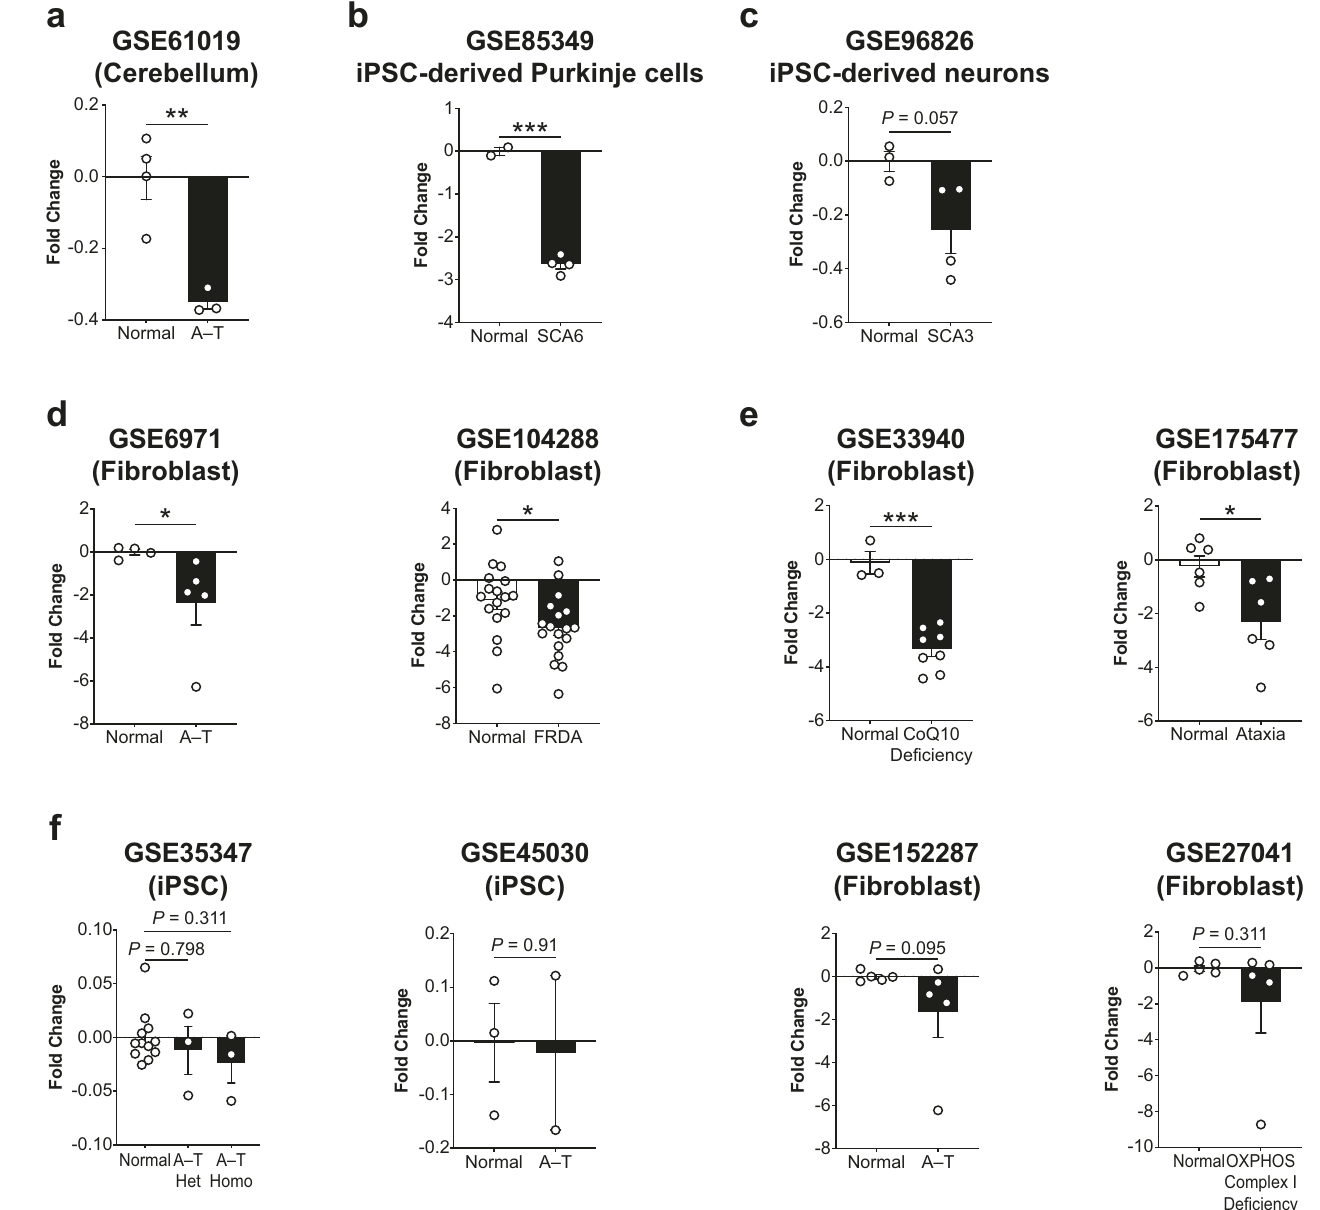
Fig. 7 GRIA1 expression is downregulated in patients with ataxic manifestations. a The mRNA expression of human GRIA1 was signi fi cantly reduced in the cerebellum of human patients with ataxia-telangiectasia (A-T). b and c Similarly, GRIA1 was downregulated in the patient iPSC- derived Purkinje cells (spinocerebellar ataxia 6) and neurons with (spinocerebellar ataxia 3). d and e GRIA1 expression were markedly reduced in the fi broblast cells derived from patients with A-T and Friedreich ’ s ataxia, and patients with ataxia symptoms. f There was a trend for GRIA1 to decrease in A-T patient-derived iPSC and fi broblasts, and fi broblast derived from patients with oxidative phosphorylation disease who exhibited ataxic manifestations. Values represent the mean ± SEM. * P < 0.05, ** P < 0.01, *** P < 0.0001; unpaired Student ’ s t -test for comparison between two groups, or one-way ANOVA followed by post hoc Bonferroni test for comparison between more than two when compared with non-ataxia patients over the same time- patients after surgery. The median nerve CMAP amplitude of non- frame of recovery. ataxia patients returned back to normal values of 8.1 ± 1.89 mV Tibial CMAP amplitudes were measured in patients from 3 to (mean ± SD for all clinical data) in 2 – 20 months after CTS surgery 38 months after being diagnosed with tibial neuropathy, in which (normal median CMAP amplitude is >4 mV 66,67 ); however, ataxia injured neurons are required to regenerate their axons over a patients recovered to a lesser extent (3.2 ± 1.80 mV; 39.5% of non- relatively long distance before they could reinnervate the target ataxia patients) after carpal tunnel decompression surgery (Fig. muscles. The mean tibial CMAP amplitude of ataxia patients was 8b). The motor nerve conduction velocity (ataxia: 52.0 ± 1.26 m/s; 0.45 ± 0.19 mV (nNCS = 8), which was much lower than the non- non-ataxia: 49.8 ± 7.88 m/s) was comparable between two groups ataxia patients (5.65 ± 2.33 mV, nNCS = 2) (Fig. 8d). In one of the (Fig. 8c). Our clinical data indicated that ataxia patients were non-ataxia patients, two additional NCSs were conducted at the unable to fully recover motor function after CTS surgical treatment